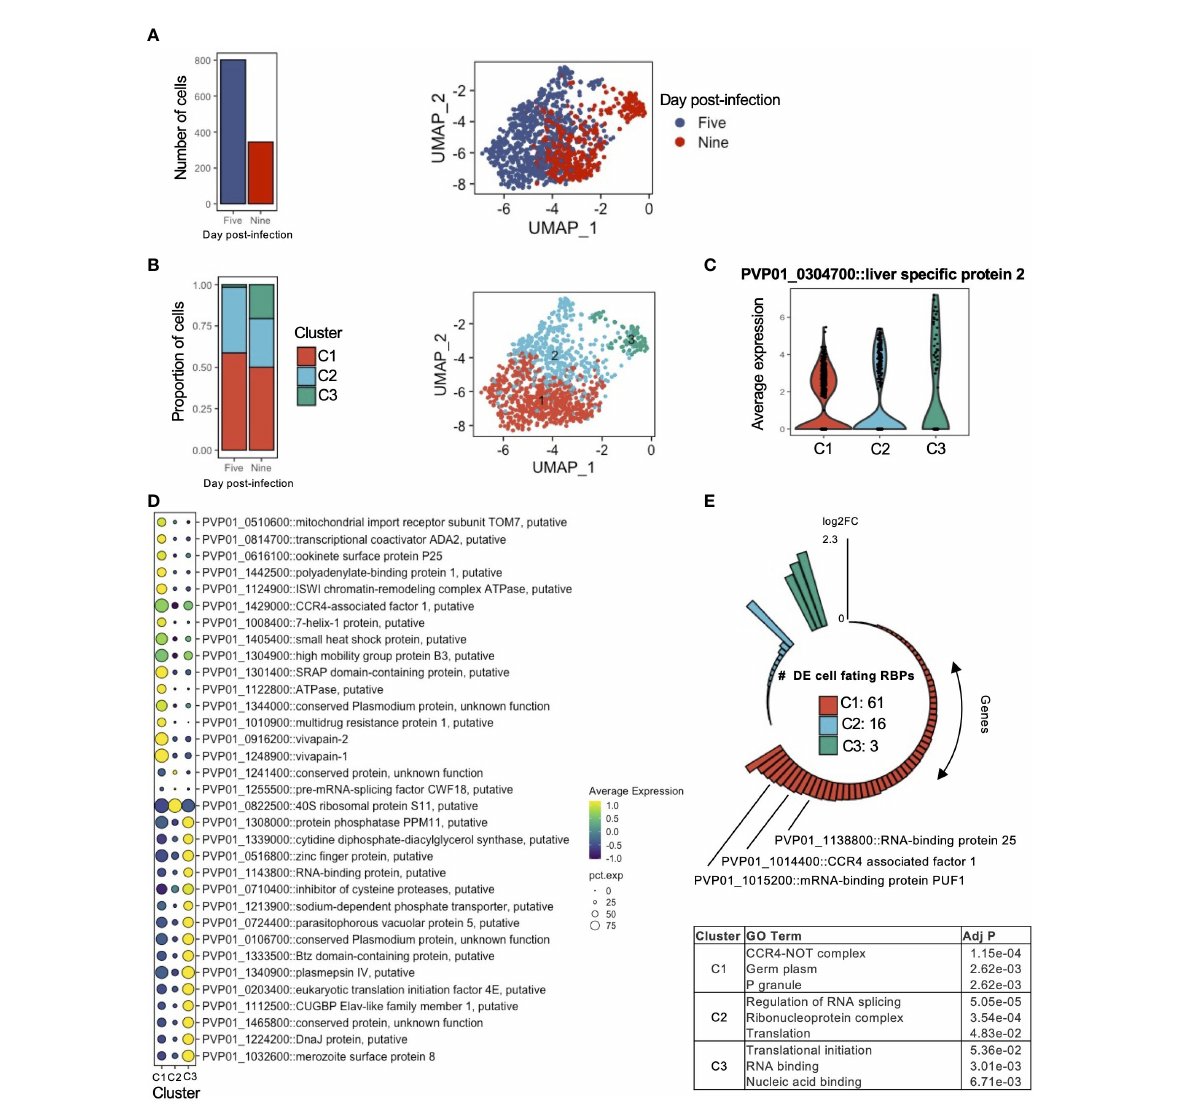
FIGURE 4 Transcriptomic signatures of activating and persister hypnozoites. (A) Number of hypnozoites assessed (left) and UMAP of cells identi fi ed as hypnozoites colored by day of collection. (B) Proportion of cells in clusters on days 5 and 9 post-infection (left) and UMAP of hypnozoites colored by cluster. (C) Violin plot showing the expression of LISP2 in each cluster. (D) Dot plot showing markers that distinguish hypnozoites in each cluster. The size of the dot corresponds the percentage of cells in the expressing the gene of interest, colored by scaled normalized expression of the transcript in each cluster. Marker transcripts were identi fi ed using Seurat ’ s AllFindMarkers function. Wilcoxon rank-sum test, average log 2 FC > 1, Bonferroni adjusted p value < 0.01. (E) Number transcripts in each cluster encoding for cellular fating RBPs sorted by their average log2FC relative to the other clusters (top) and GO Term enrichment of genes in each cluster (bottom). Adj P: Bonferroni adjusted p